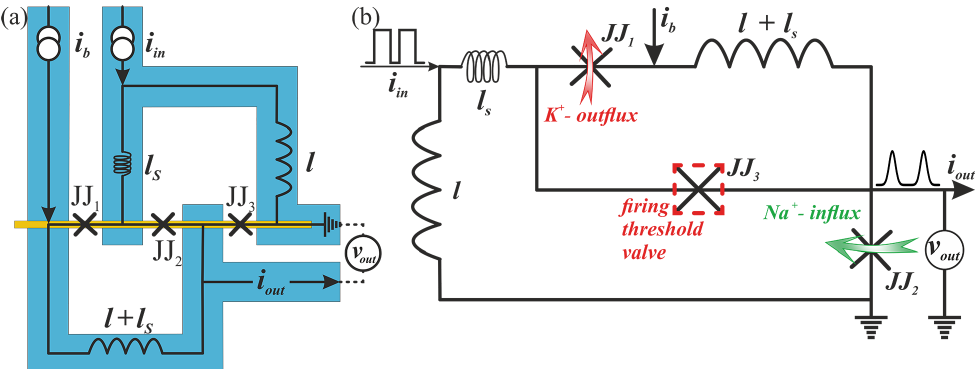
Figure 3. ( a ) Sketch of the proposed superconducting bio-inspired neuron with nanowire-based Josephson junctions. ( b ) Schematic of the proposed bio-inspired